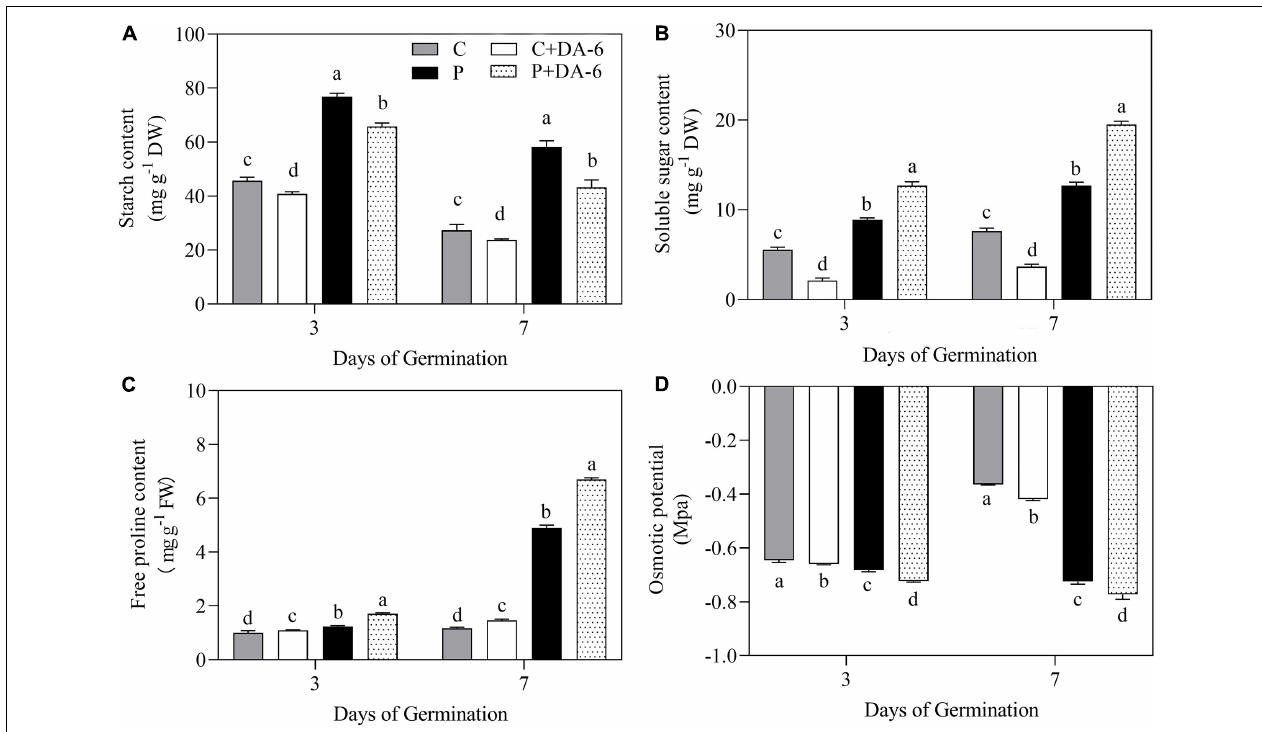
FIGURE 5 | Effect of seed priming with distilled water or DA-6 (2 mM) on (A) starch content, (B) soluble sugars content, (C) free proline content, and (D) osmotic potential after 3 and 7 days of germination in white clover under well-watered condition and drought stress. Different letters above different treatments represent significant differences at a specific time point under well- watered condition or drought stress ( p ≤ 0.05). Vertical bars show the ± SE of mean (n =